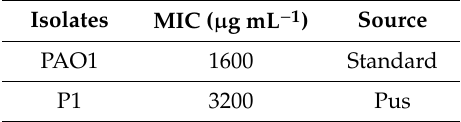
Table 1. MIC values of BM-ZnO NPs against P. aeruginosa (PAO1 and clinical